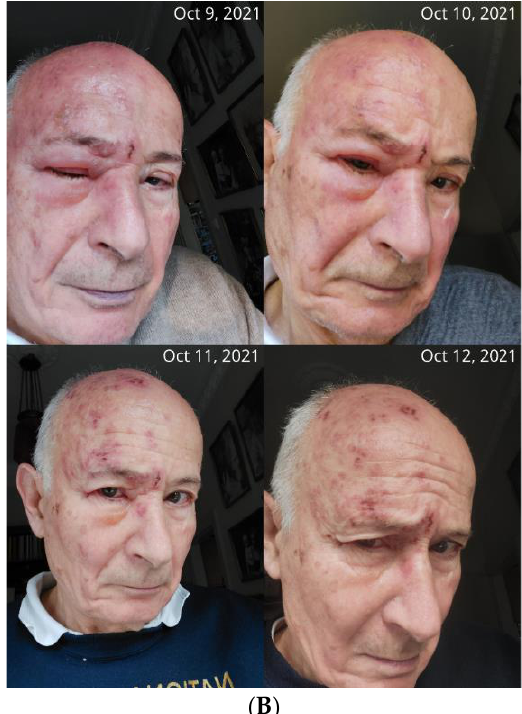
Figure 1. ( A ) Disease and treatment course: dateline of herpes zoster ophthalmicus and its treatment from 30 September to 14 October 2021. Extended lines represent the start of symptoms and treatment. Days highlighted in gray illustrate treatment with IBDV. ( B ) The author ’ s HZO with orbital edema at the peak of disease and in recovery. The “ selfie ” pictures were taken between 9 October 2021 and 12 October 2021. Consent to the publication of patient information was granted by Tibor Bakacs, M.D., Ph.D., D.Sc., as he was the patient and the treating physician in this autobiography. Reproduced from Bakacs, T. Healing of Severe Herpes Zoster Ophthalmicus Within a Few Days: An Autobiographical Case Report. Cureus . 2021, 13:e20303. doi:10.7759/cureus.20303 [7] with permission from Cureus Inc. (see in 8. Site Content and User Submissions; https://www.cureus.com/terms; accessed on 29 January 2023).